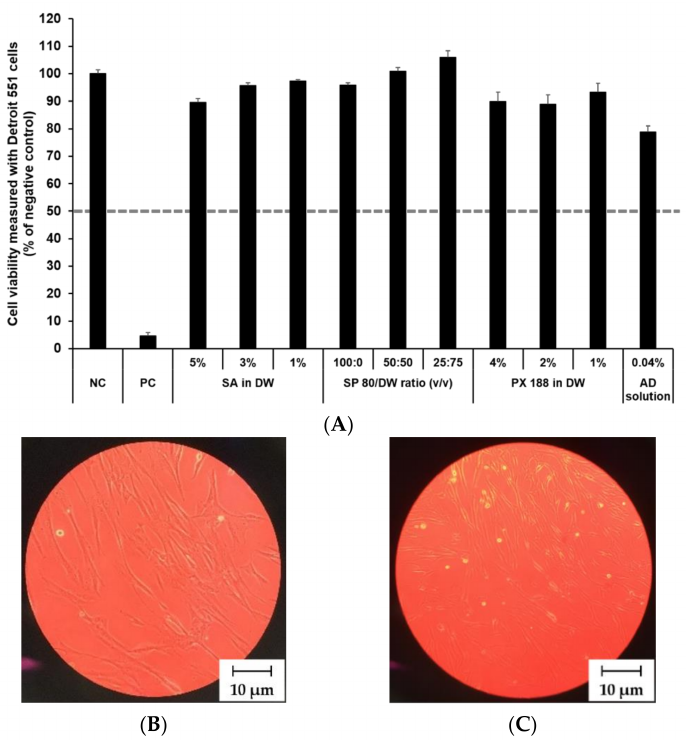
Figure 8. Irritation study and morphological evaluation using Detroit 551 cell line. ( A ) Viability of Detroit 551 cells treated with SLN components and AD solution, ( B ) the native morphology of Detroit 551 cells, and ( C ) nanoparticle-treated morphology of Detroit 551 cells. Cell viability was measured using MTT assay. The values greater than 50% (dotted line) indicate that test materials are non-irritant to the skin. Results are expressed as mean ± standard deviation of three independent experiments ( n = 3). NC: DPBS; PC: 5% SDS solution; SA: Stearic acid; DW: Distilled water; SP 80: Span 80; PX 188: Poloxamer 188, AD: